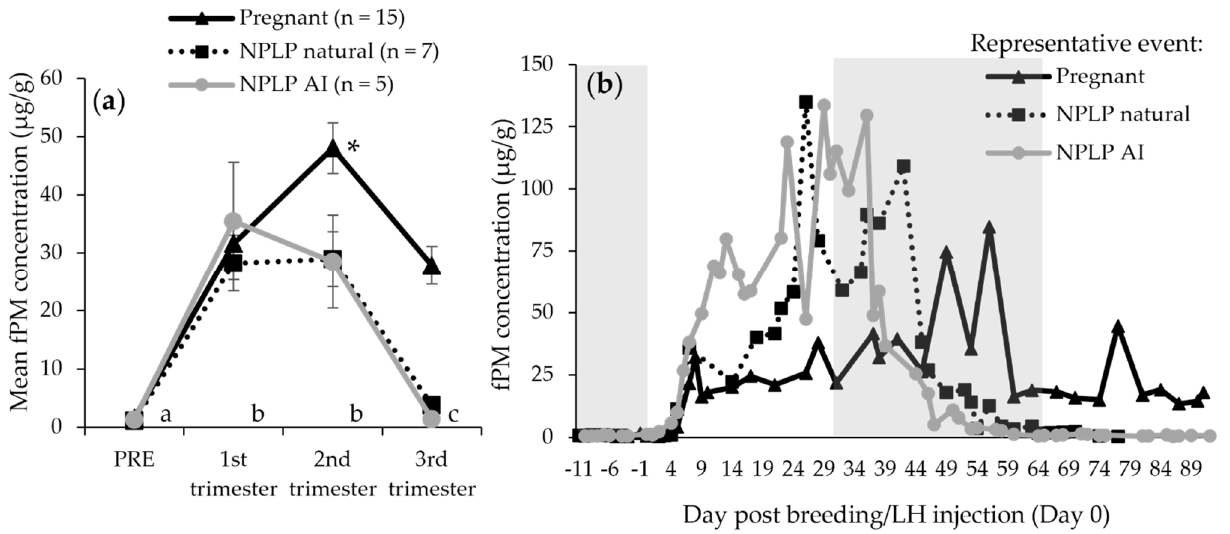
Figure 1. Time period raw means ( a ) and three representatives ( b ) fecal progestagen metabolite (fPM) profiles for female cheetahs experiencing ovulatory events: pregnant, confirmed by birth of cubs, or a non-pregnant luteal phase (NPLP) following natural breeding or exogenous hormone stimulation and artificial insemination (AI), but no cubs resulted. In ( a ), different lower-case letters denote differences ( p < 0.05) among time periods for all ovulatory events. Asterisk indicates a difference from other trimesters in the pregnant condition only. In ( b ), alternatively shaded sections indicate PRE time period and three trimester divisions.